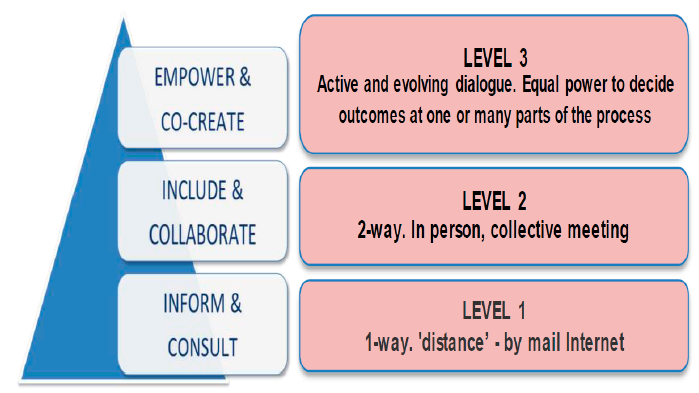
Figure 2. REMOURBAN model for citizen engagement [3].